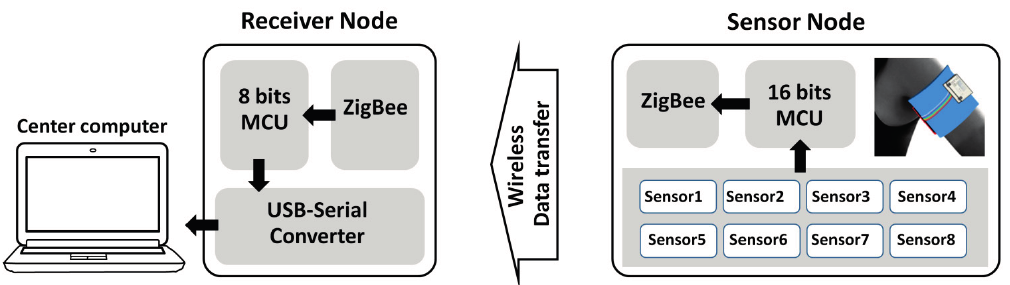
Figure 4. Working principle of the wearable e-nose based on ZigBee wireless network